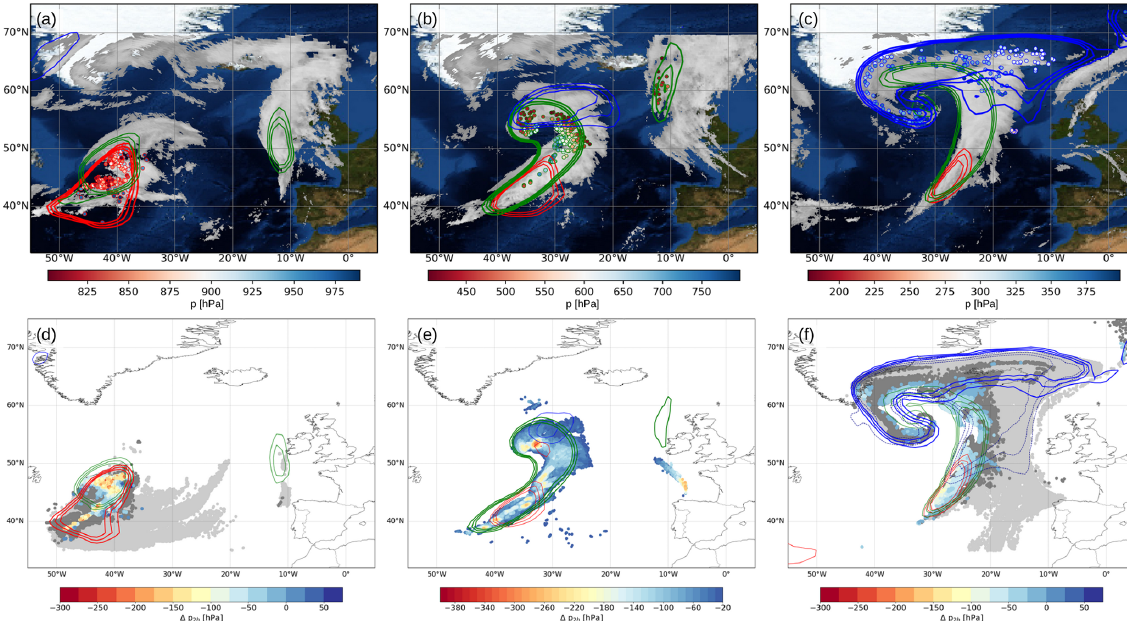
Figure 6. Synoptic evolution of WCB case study on (a, d) 4 October 2016 at 00:00UTC, (b, e) 4 October 2016 at 12:00UTC, and (c, f) 5 October 2016 at 00:00UTC. Panels (a) to (c) are based on ERA-Interim and show conditional probability of WCB inflow (red contours), ascent (green contours), and outflow (blue contours) all at 0.2, 0.3, and 0.4. Dots show locations of trajectory-based WCB air parcels for (a) inflow, (b) ascent, and (c) outflow and are colored according to their pressure (hPa). Also shown are IR GridSat clouds (Knapp et al., 2011) with a brightness temperature of less than − 10 ◦ C. Panels (d) to (f) are based on convection-permitting simulations with the ICON model. Contours are the same as in (a–c) except for (f) where the dashed blue contour denotes the conditional WCB outflow probability calculated with the standard model of Part 1. Dots show trajectory-based WCB air parcels for (d) inflow, (e) ascent, and (f) outflow that will transition to the ascent layer in the next hour (colored dot) or have just arrived in the outflow layer (color indicates 2h pressure change), that have been in the layer for 1–6h (dark gray dots), and that have been in the corresponding layer for more than 6h (light gray dots),